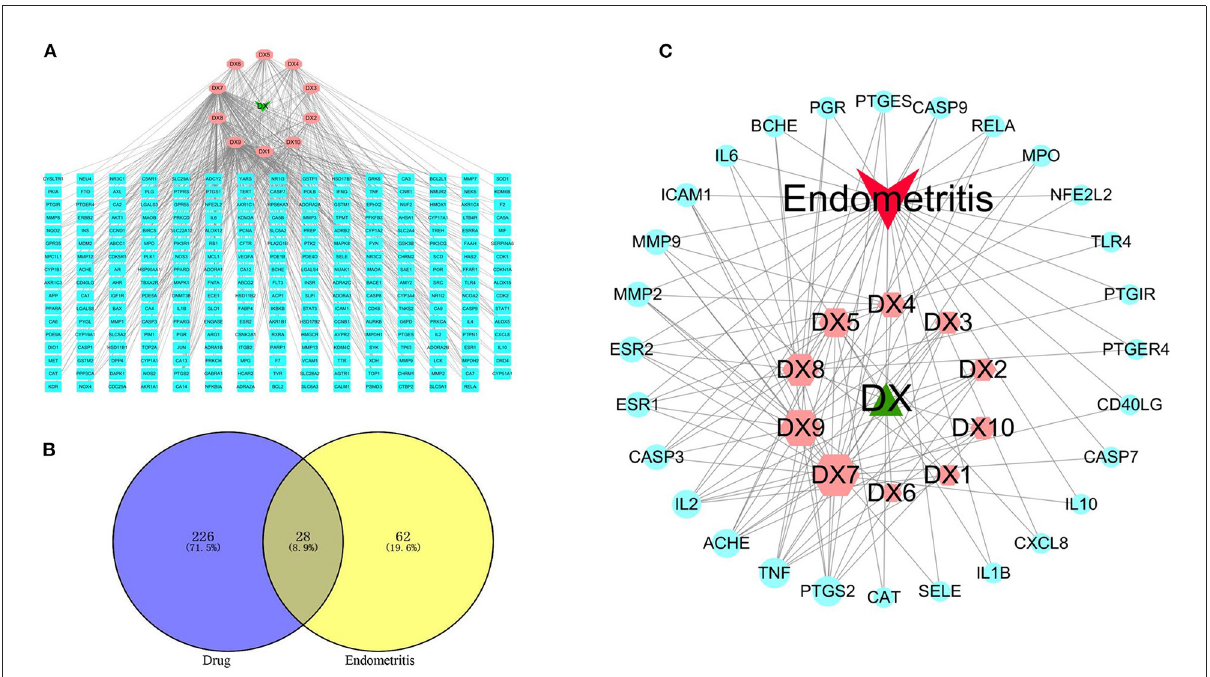
FIGURE2 Key active components prediction for SOL treatment of endometritis. (A) Compound–target network. The green node represents SOL, the pink nodes represent candidate active components, and the blue nodes represent the targets of SOL components. The lines represent the interactions between them. (B) The common targets of SOL and endometritis were identified. (C) Compound–target–disease network. The green node represents SOL, the red node represents endometritis, the pink nodes represent candidate active components, and the blue nodes represent common targets. The lines represent the interactions between them. A large size represents a higher